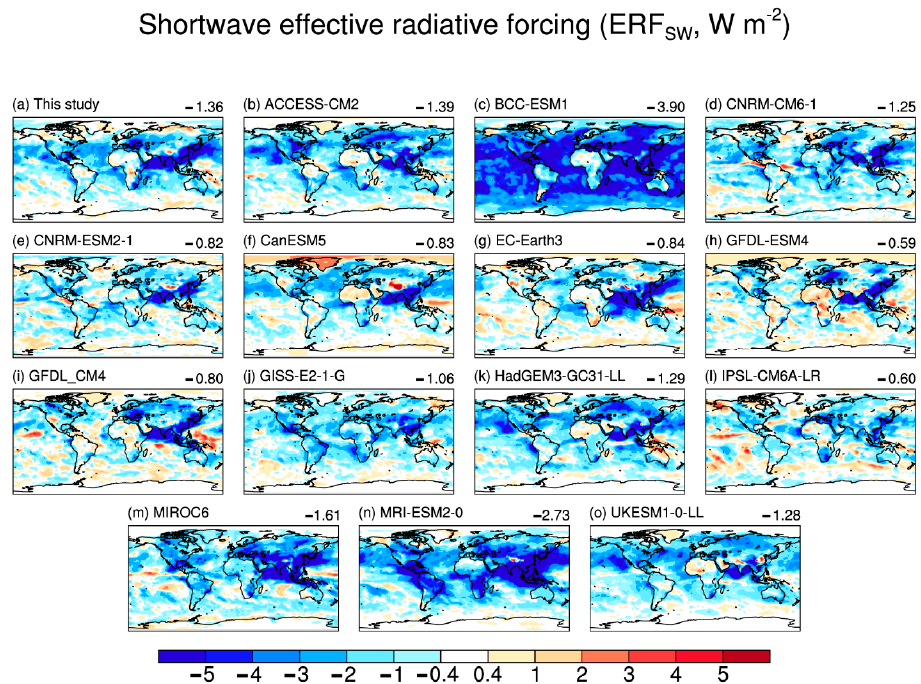
Figure 5. Comparison of annual mean shortwave effective radiative forcing in this study ( a ) and the 14 available ( b – o ) CMIP6 model